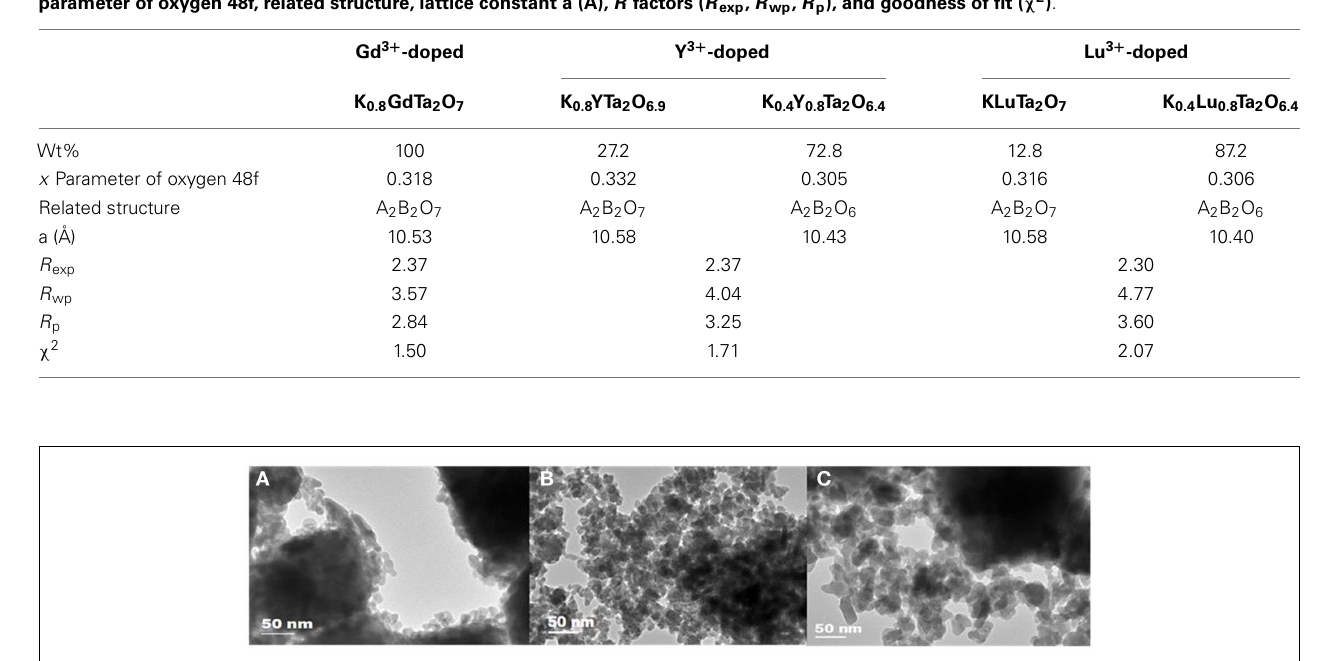
Table 2 | Rietveld refinement parameters of the nano-sized tantalate pyrochlore: nominal compositions, weight percentage of each phase, x parameter of oxygen 48f, related structure, lattice constant a (Å), R factors ( R exp , R wp , R p ), and goodness of fit ( χ 2 ) .